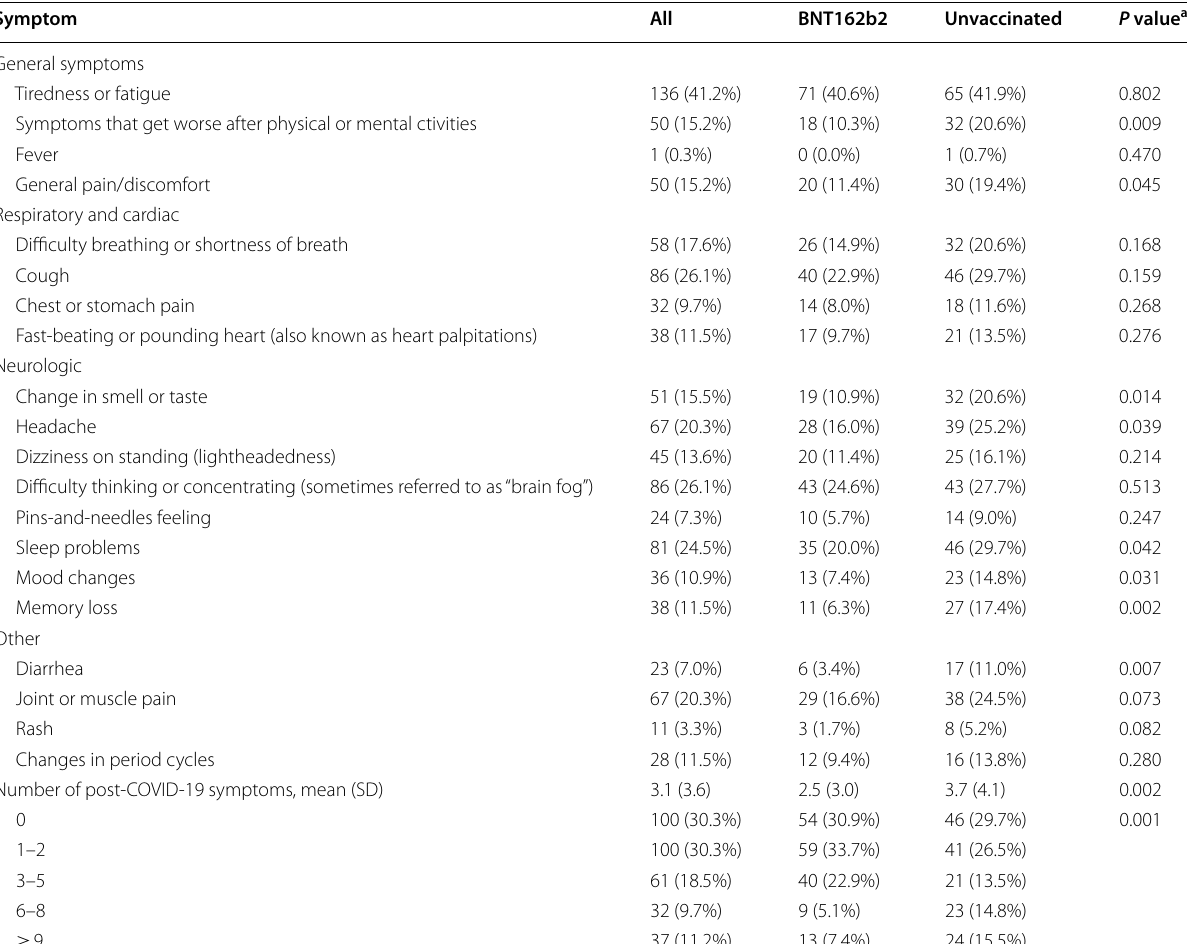
Table 2 Post-COVID-19 symptoms at week